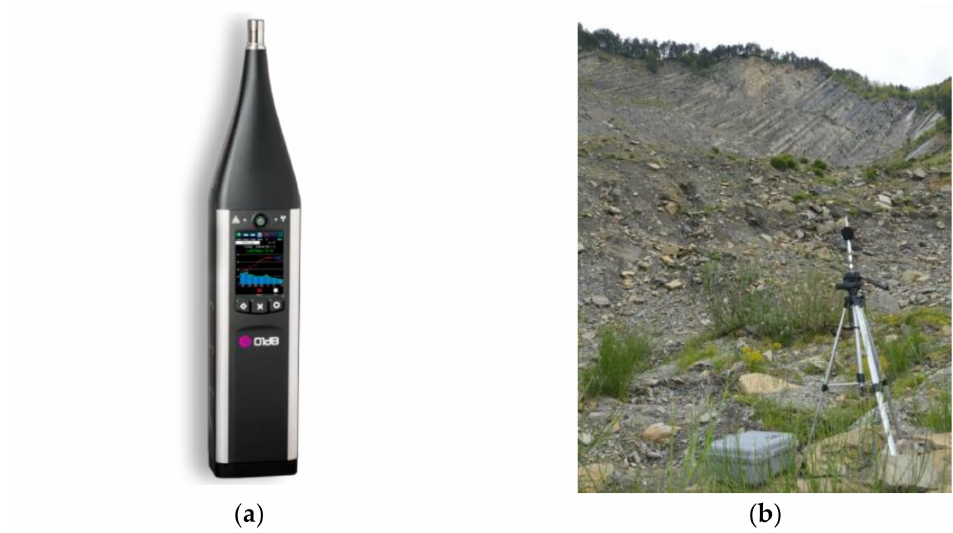
Figure 4. Overview of the 01dB DUO Smart Noise Monitor: ( a ) DUO instrument body in LOG mode; ( b ) Outdoor microphone unit DMK01 and the waterproof case DSC01 containing the instrument body during the rockfall monitoring campaign carried out at the